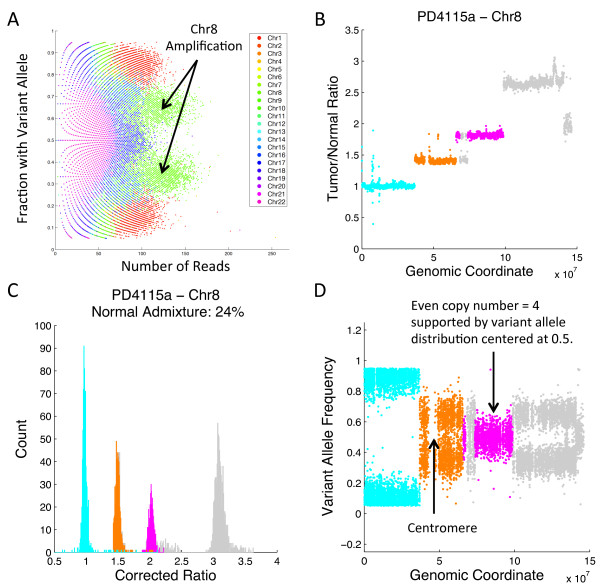
Analysis of chromosome 8 in sample PD4115a. (A) Virtual SNP array data from this sample show few distinct clusters (compared with the 188× sample in Figure 3A), with amplification of chromosome 8 (green) being the most prominent. (B) Read depth ratios for chromosome 8 organized by genomic coordinate. (C) Histograms of read depth ratios for chromosome 8 corrected for 24% normal admixture, indicating regions of copy numbers 2, 3 and 4 (cyan, orange and pink), with the latter two being clonal amplifications. (D) Variant allele frequencies for chromosome 8. The region with copy number 4 (pink) has variant allele frequencies clustered around 0.5, suggesting duplication of both chromosomal homologs, while the telomeric region with copy number 2 (cyan) has a loss of heterozygosity, suggesting a copy neutral LOH event. LOH: loss of heterozygosity